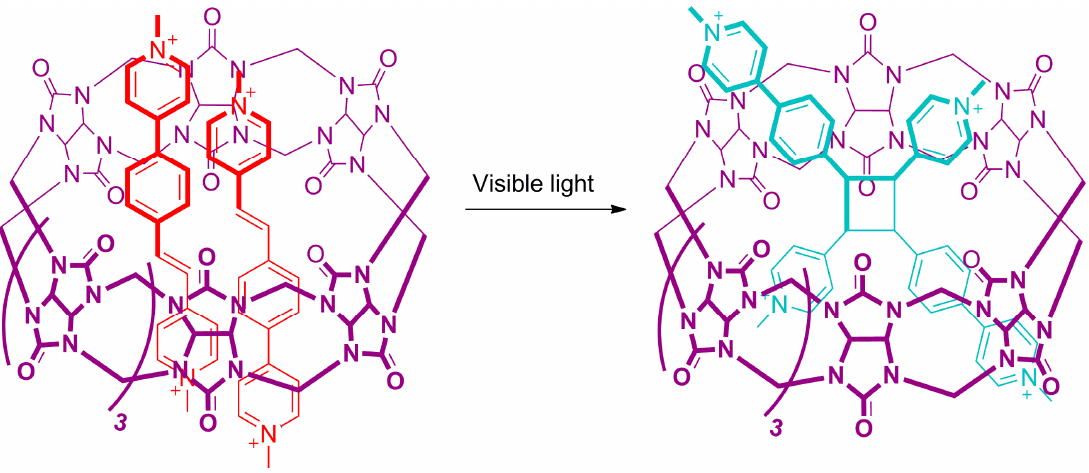
Figure 17. Cucurbit [8]uril-promoted [2 + 2] photodimerization reaction of styrylpyridinium guest molecules reported by Professor Gao’s research group [131].